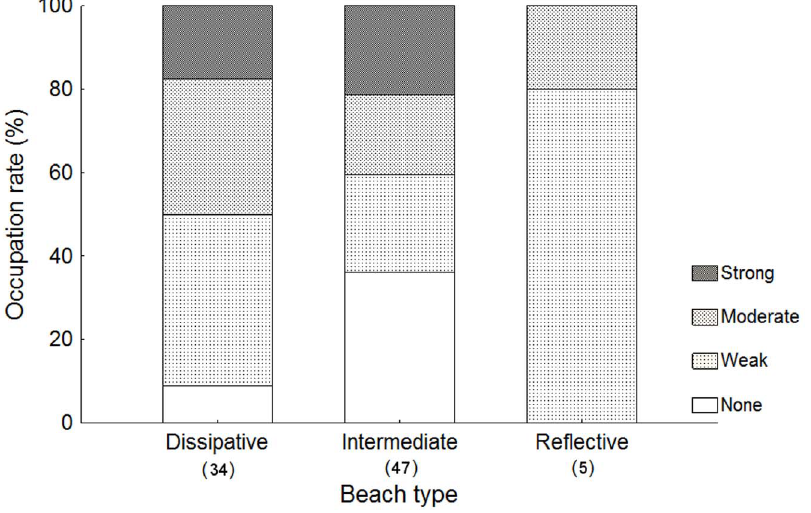
Figure 4. Relative intensity of signs around occupied burrows by beach type. Intensity of signs of Ocypode quadrata activity around occupied burrows. None – no sign of occupation; Subtle – only the internal perimeter definition and/or any other, barely recognizable sign could be noted; Moderate – Visible presence of sand and/or tracks; Strong – one of the above signs very obvious and/or presence of more than one visible sign. Covered or semi-covered burrows were also assessed. The number of animals caught on each type of beach is shown in parentheses below the x axis.